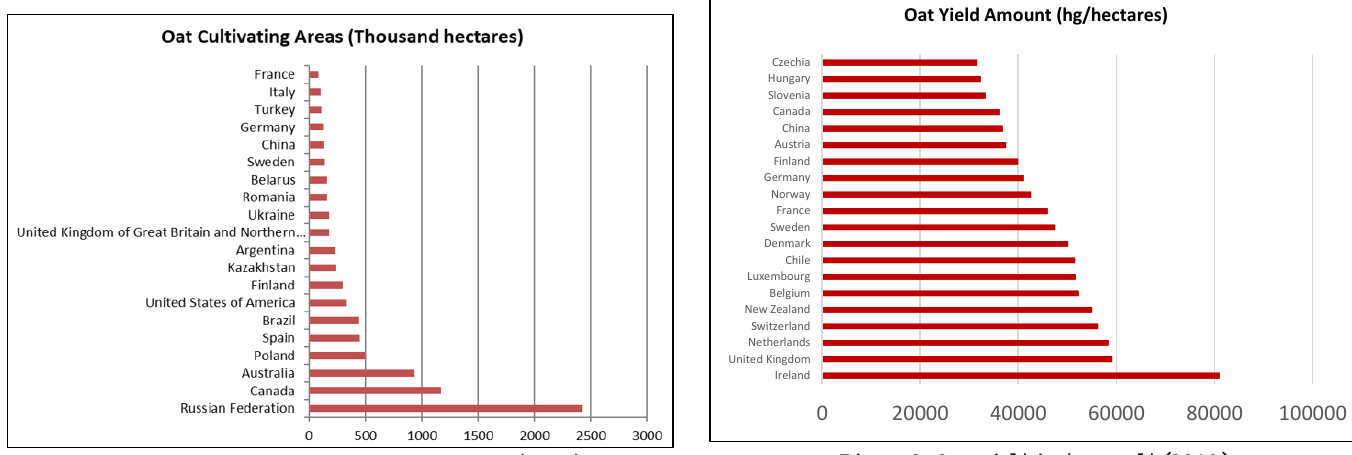
Figure 1: Oat cultivation area in the world (2019). Source: [22].